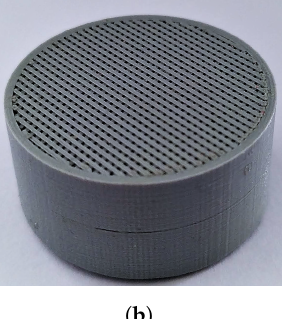
Figure 1. Photograph and schematic design of the generic porous media samples. ( a ) Design variables used to parameterize the material properties [36]. ( b ) Photograph of a printed generic porous media sample